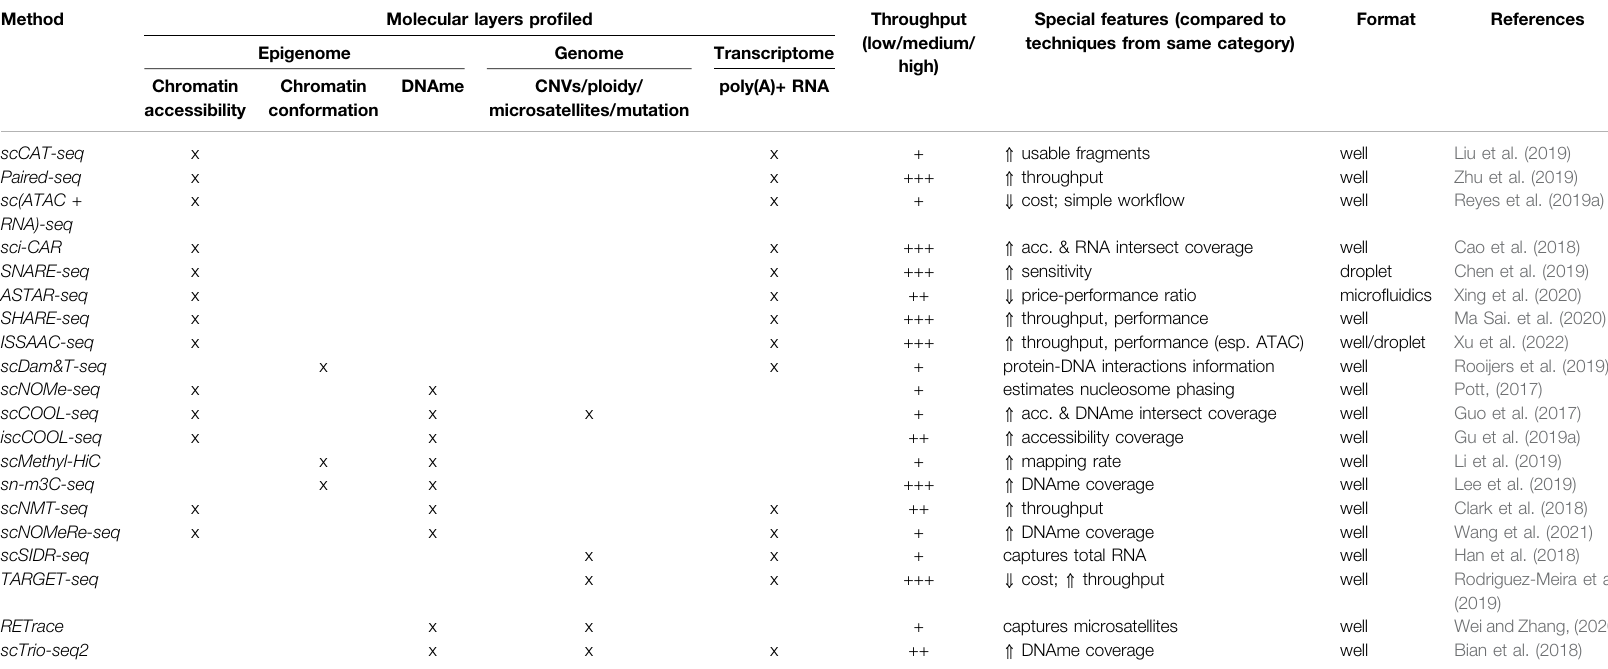
TABLE 1 | Summary of reviewed single-cell multiomics